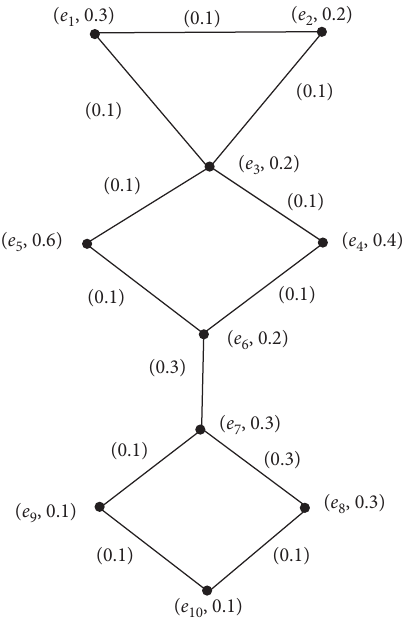
Figure 11: Fuzzy graph G � ( J , K )